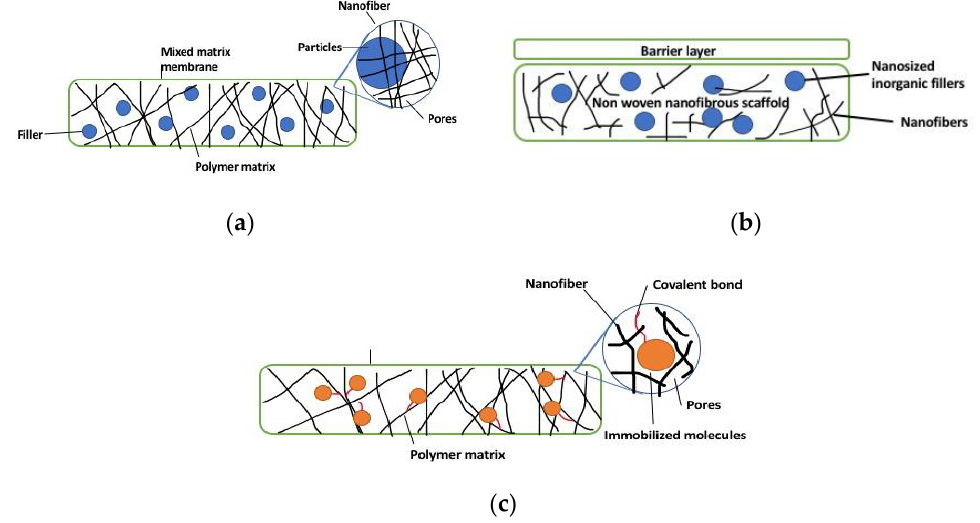
Figure 4. ( a ) Mixed-matrix nanocomposite, ( b ) hybrid nanocomposite, and ( c ) surface-functionalized nanocomposite membranes.